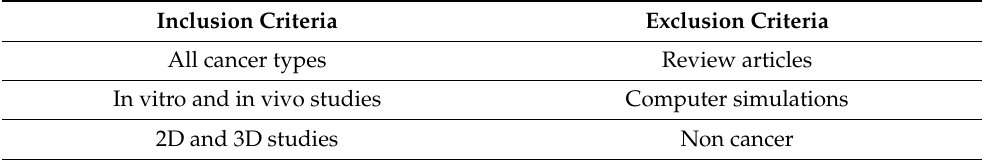
Table 2. Inclusion and exclusion criteria.